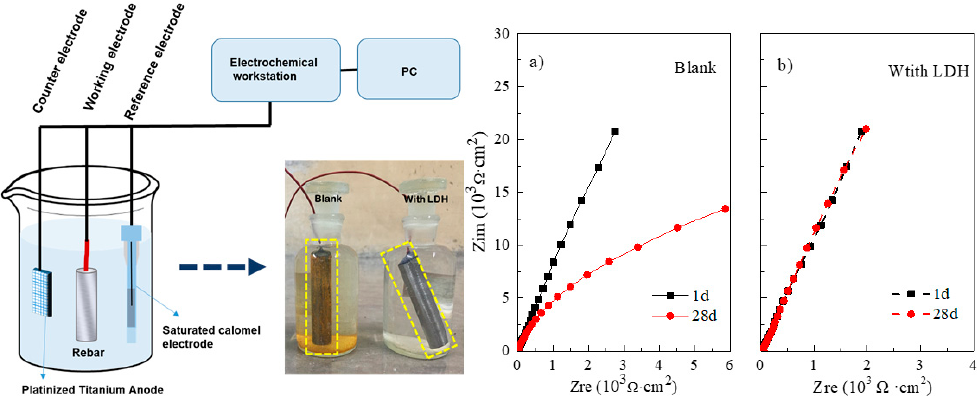
Figure 6. The schematic of the electrochemical (left); the corrosion state of steel bars immersed in two electrolytes after 28d (middle); the impedance spectra plots of steel immersed in two electrolytes (with/without inhibitor) at 1d and 28d ( a , b ).